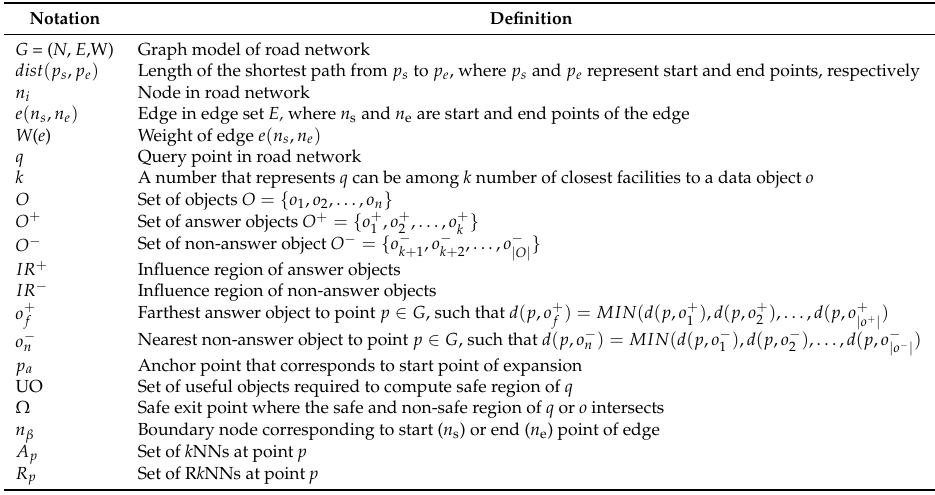
Table 1. Summary of notations used in this paper.